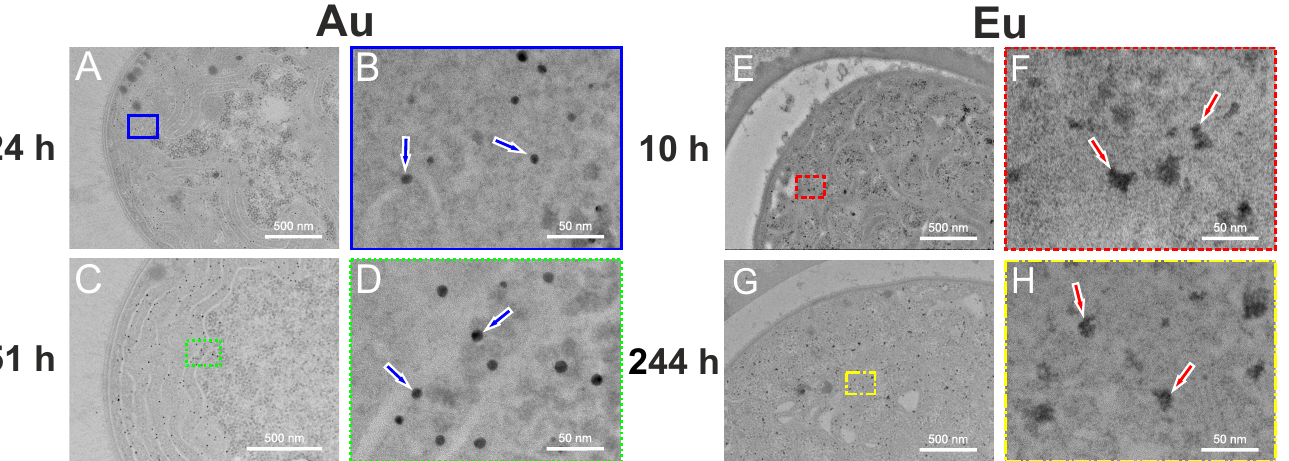
Figure 1. TEM images of vegetative cells of Anabaena sp. showing Au-NPs after 24 h ( A , B ) and 51 h ( C , D ) and its heterocysts with Eu-NPs after 10 h ( E , F ) and 244 h ( G , H ). Indicated are magnifications ( B ) (blue outline) of ( A , D ) (green dotted) of ( C , F ) (red dashed) of ( E ), and ( H ) (yellow dotted and dashed) of ( G ). Blue arrows mark some selected Au-NPs and red arrows